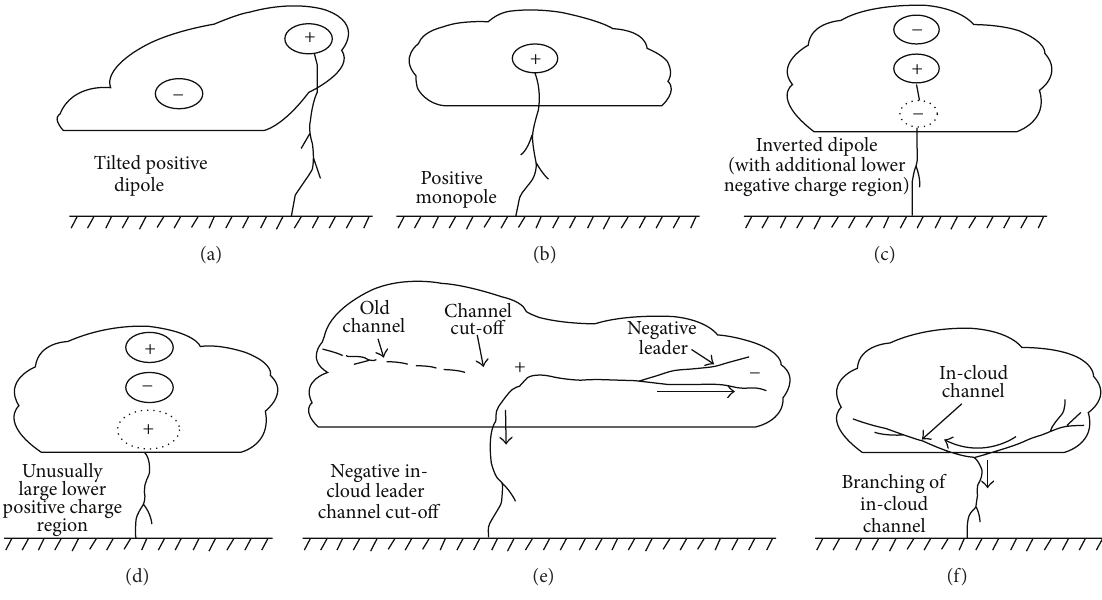
Figure 4: Conceptual cloud charge configurations and scenarios leading to production of downward positive lightning [1]. Table 1: The statistical summary of the electric field parameters produced by positive lightning first and subsequent strokes as recorded at UTM observatory building.